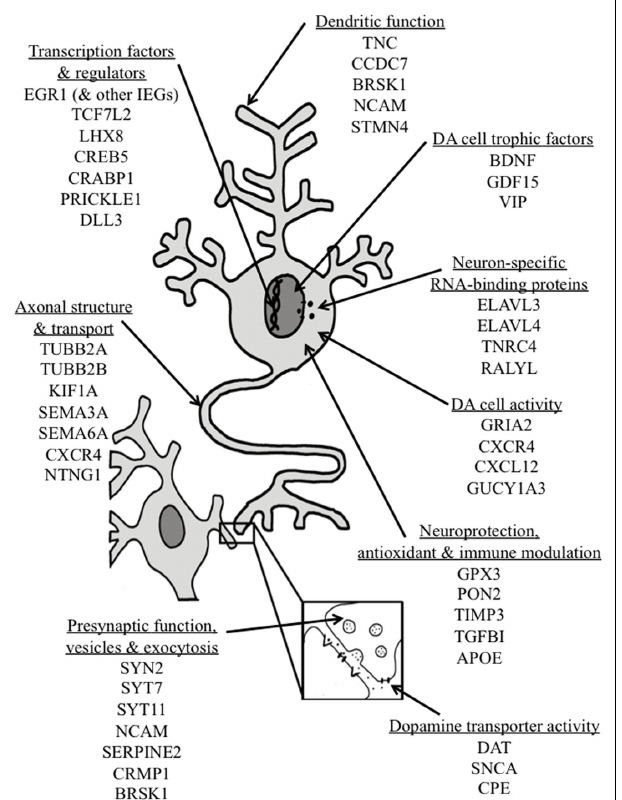
FIGURE 5 | Schematic representation of multiple sites of action through which NURR1 regulation of gene expression may contribute to DA cell development, phenotypic stability, neuroprotection or functional recovery. Some specific genes robustly regulated by NURR1 are grouped according to their primary biological processes; many are known to modulate DA neuronal activity and/or have been associated with DA-related diseases such as Parkinson’s disease or drug abuse. Abbreviations for gene names are indicated in the text and supportive gene expression data are provided inTable S1 in Supplementary